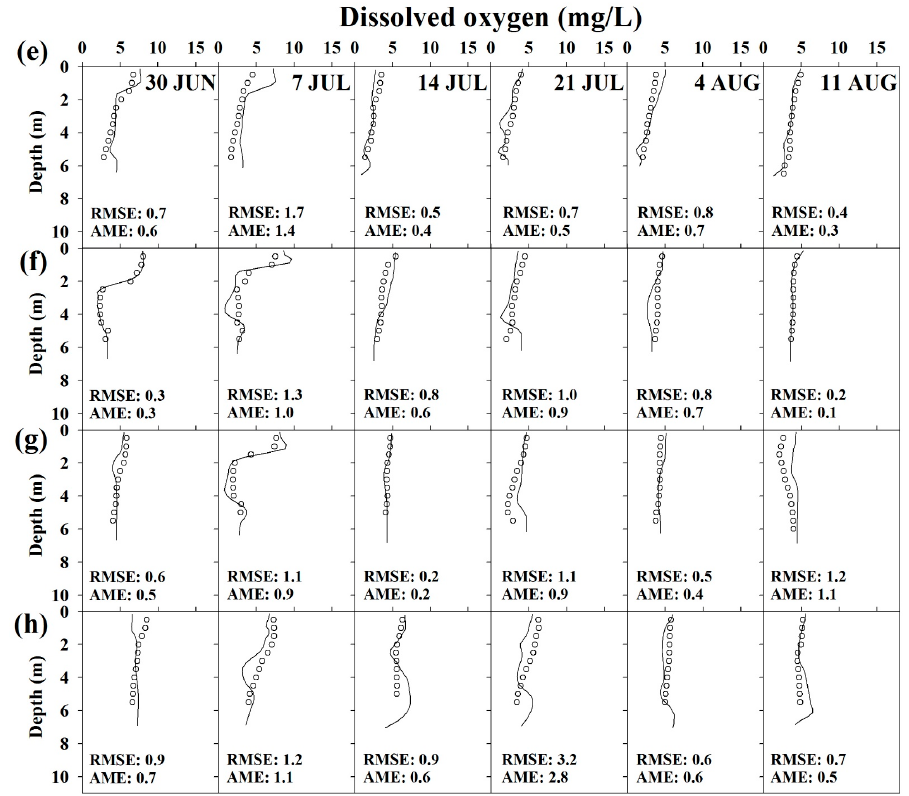
Figure 7. Vertical profiles of salinity and DO concentration observed and predicted at ( a , e ) S1; ( b , f ) S2; ( c , g ) S3; ( d , h ) S4.